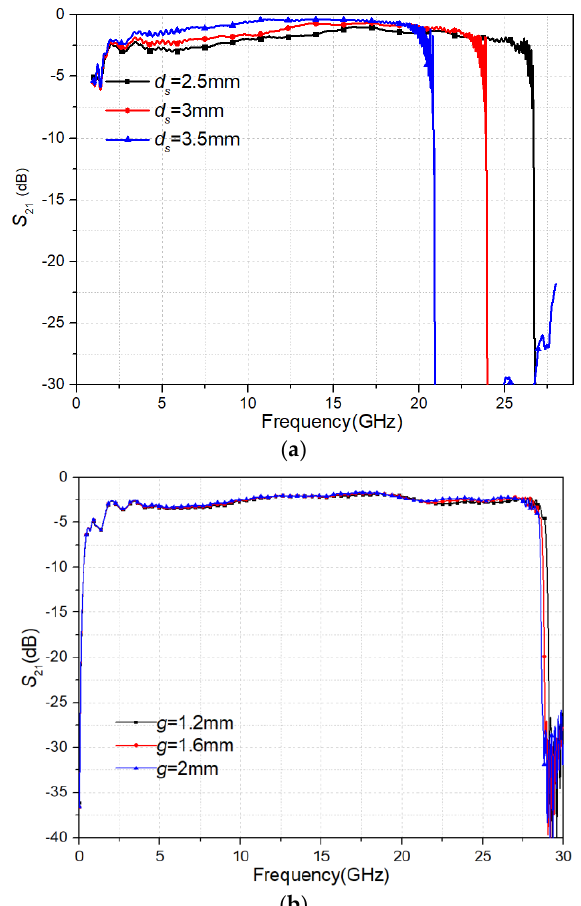
Figure 5. The simulated S 21 of SSPP TL with different size of slots. ( a ) Different ds when p = 1.6 mm; ( b ) different g when ds = 2 mm.